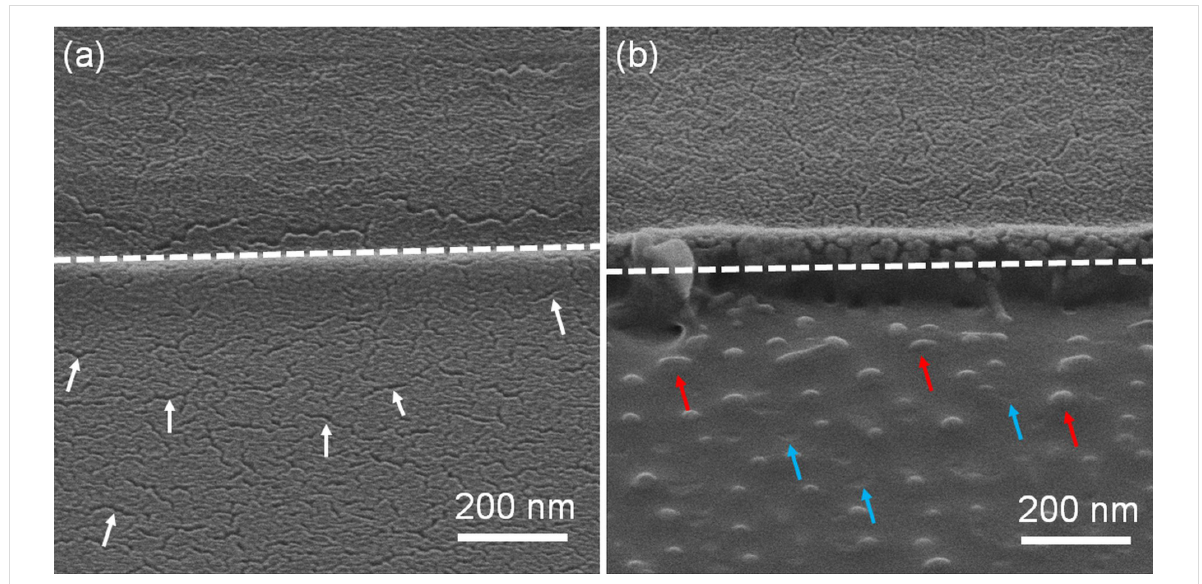
Figure 3: Helium ion microscopy (HIM) images of a 5 nm Pt 60 Pd 40 /200 nm PMMA sample irradiated at a fluence of 1.2 × 10 16 cm − 2 with He + (a) and Ga + FIB (b). In (a) and (b), dashed lines indicate the border between the irradiated (lower parts) and non-irradiated regions (upper parts). White arrows in (a) indicate some nanoscale cracks. In (b), red and blue arrows indicate local surface elevations and erosions, respectively. Both images are taken at a 54° tilt angle of the sample